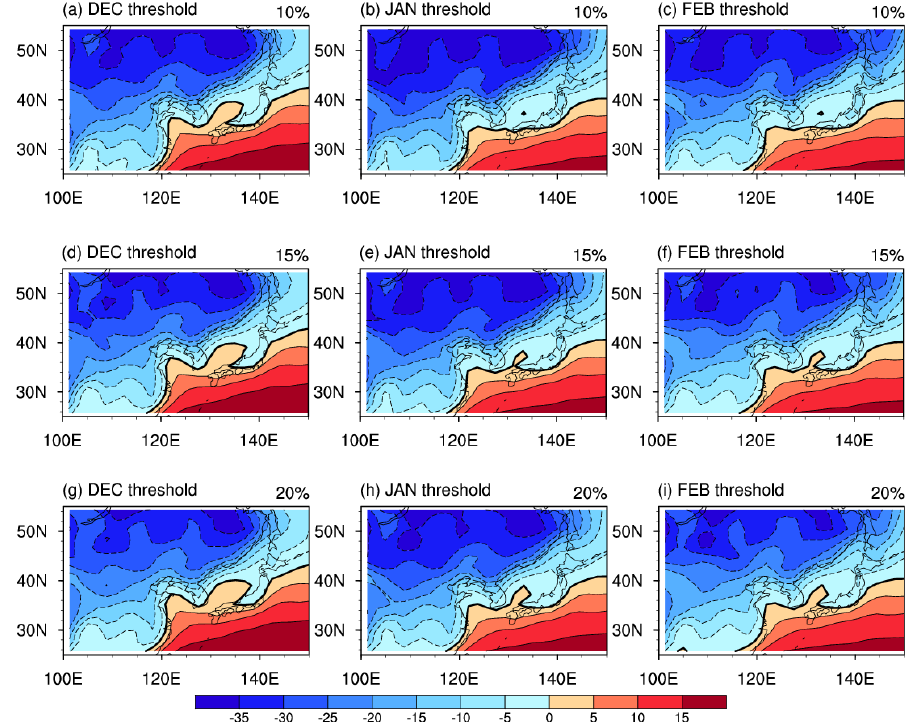
Figure 1. Definition of NCD. Threshold values (°C) defined NCD over East Asia, which were 10th percentile of Tmin_2m within the month of ( a ) December, ( b ) January, and ( c ) February. The contour interval (CI) was 5 °C. ( d – f ) and ( g – i ) the same as ( a – c ), but for the 15th and 20th, respectively.